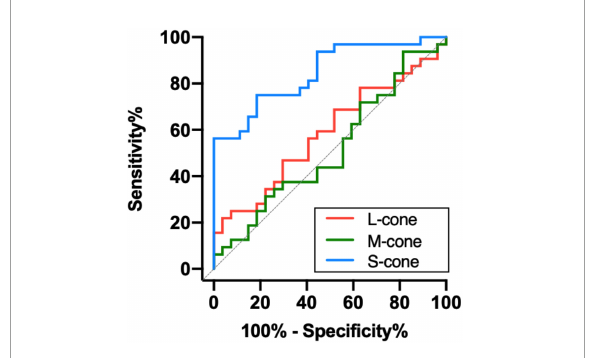
FIGURE4 Receiver operating characteristic analysis of the chromatic sensitivity in the TAO patients without clinical signs of